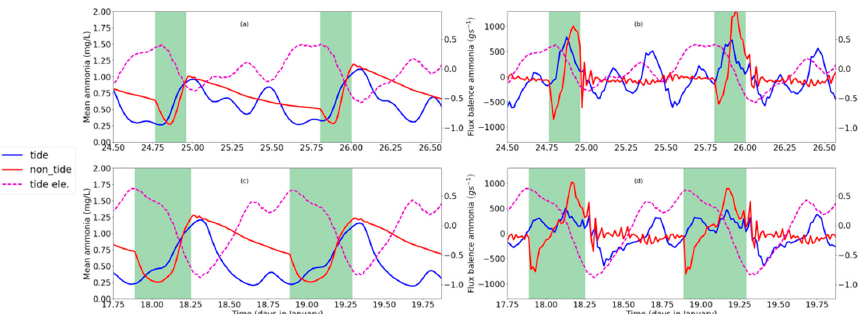
Figure 5. The averaged concentration of ammonia in the cross-section between the HMB (tide gate) and breakwater in the neap ( a ) and spring phase ( c ). The balance of ammonia flux (seaward flux from HMB minus seaward flux from breakwater) during the neap ( b ) and spring ( d ) phase. Seaward transportation is a positive value. Concentrations and flux of ammonia in the tide-receiving scenario are in blue and non-tidal scenario in red. Water surface elevation is also plotted in dash lines in magenta to indicate the tidal phase. The tide gate opening period is marked out by the green shadow.